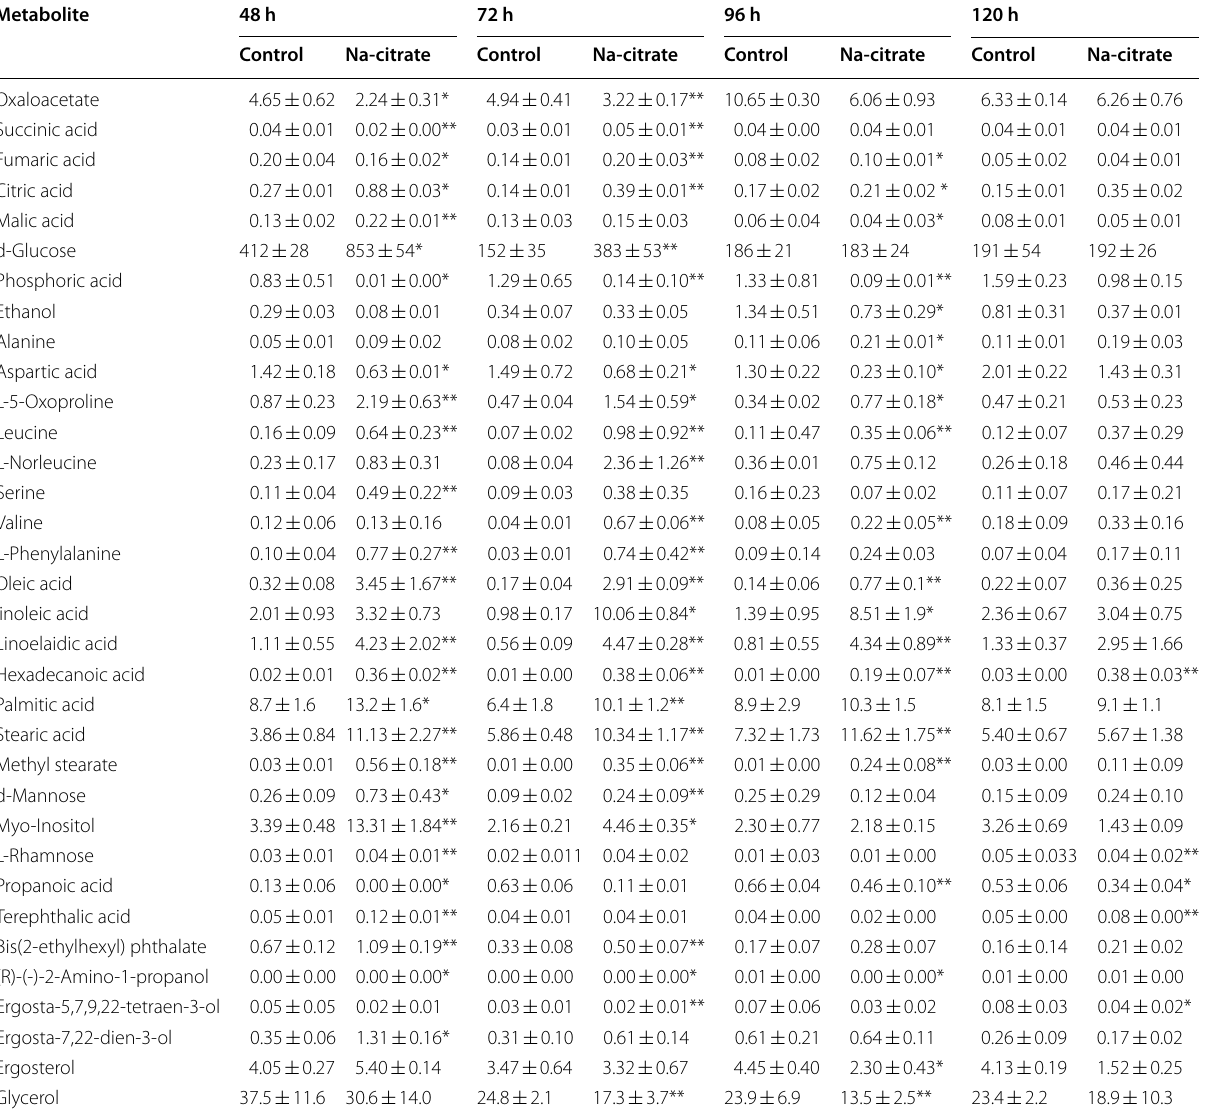
Table 2 The metabolites responsible for responding to Na-citrate in X. dendrorhous